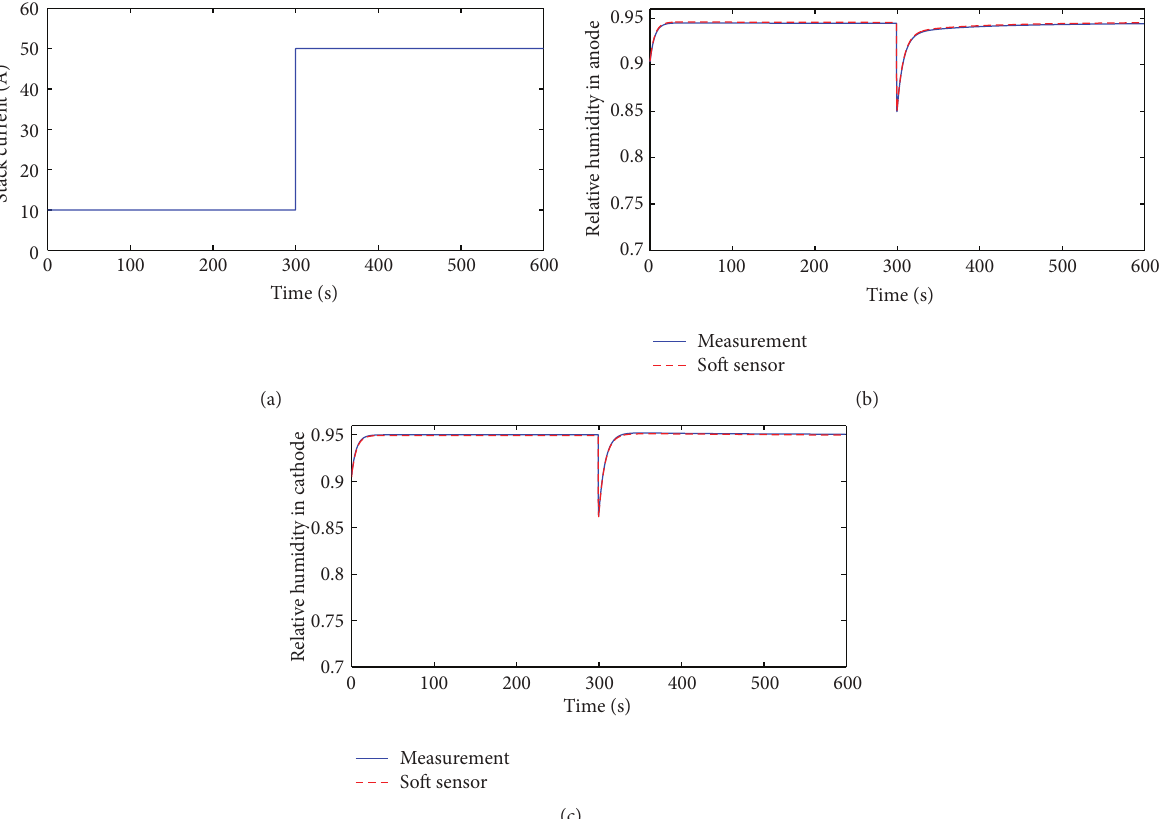
Figure 9: Comparison of measured and soft sensor’s relative humidity with stepped change of stack current. (a) Stack current 𝐼 (c)